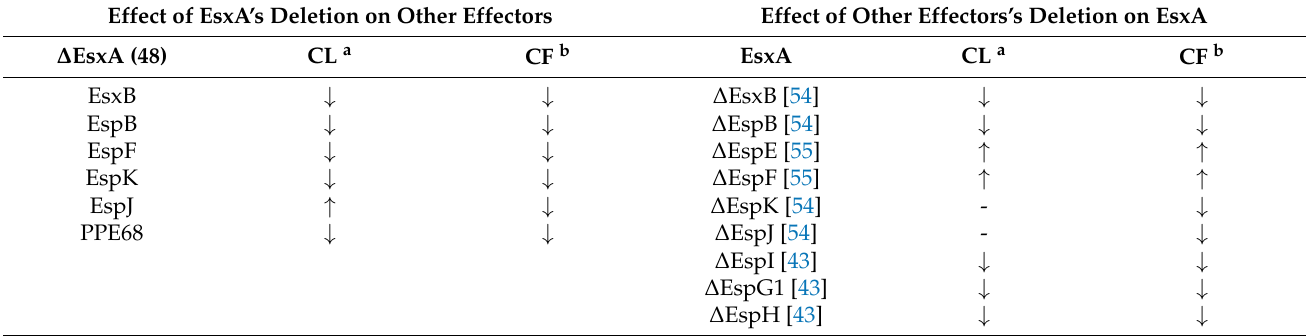
Table 1. Expression and secretion co-dependence among ESX-1 effectors. Effect of EsxA’s Deletion on Other Effectors Effect of Other Effectors’s Deletion on